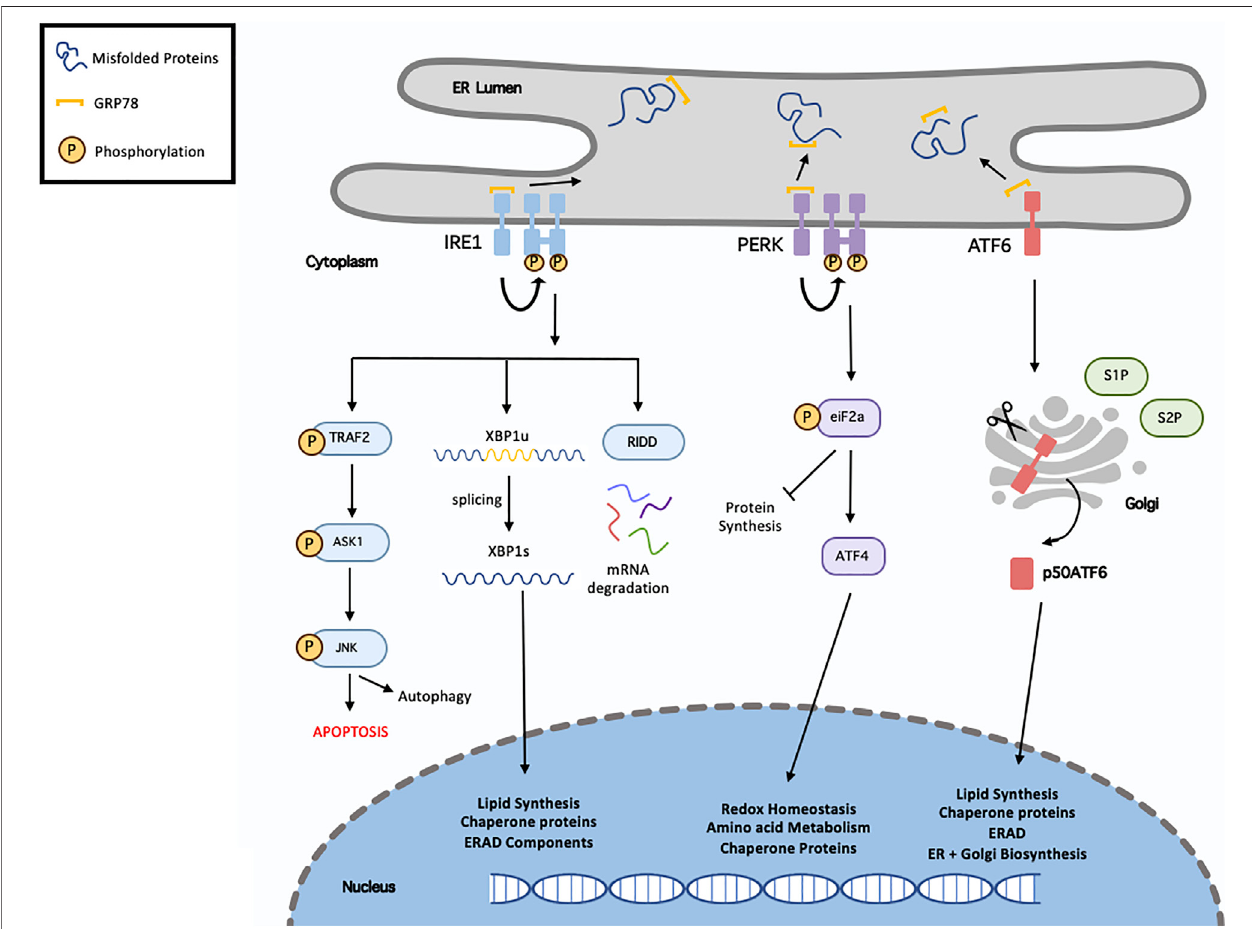
FIGURE 3 | Overview of unfolded protein response. Following endoplasmic reticulum (ER), misfolded/unfolded proteins bind and sequester GRP78 (Binding immunoglobulinprotein),thusactivatingtheunfoldedproteinresponse(UPR).Thisresultsinactivationofthethreesignallingcascades,IRE1(inositolrequiringenzyme1), PERK (protein kinase RNA-like ER kinase) and ATF6 (activating transcription factor-6). Following dissociation from GRP78, IRE1 undergoes homodimersation and autophosphorylation. It can then induces XBP1 (x-box binding protein 1) splicing, activated RIDD (regulated IRE1-dependent decay) or recruits TRAF2 (TNF receptor associated factor 2) resulting in ASK1 (apoptosis signal-regulating kinase 1) phosphorylation, which then phosphorylates the c-Jun N-terminal kinase (JNK). Activation of the PERK pathway, results in eIF2 α (eukaryotic translation initiation factor 2 α ) phosphorylation, which in turn inhibit protein synthesis and activate ATF4 (activated transcription factor 4). In terms of ATF6, it translocates to the Golgi where it is cleaved and migrates to the nucleus. XBP1, ATF4 and ATF6 regulate various genes called in chaperone proteins synthesis, ER-associated degradation (ERAD), lipid synthesis and redox homeostasis.